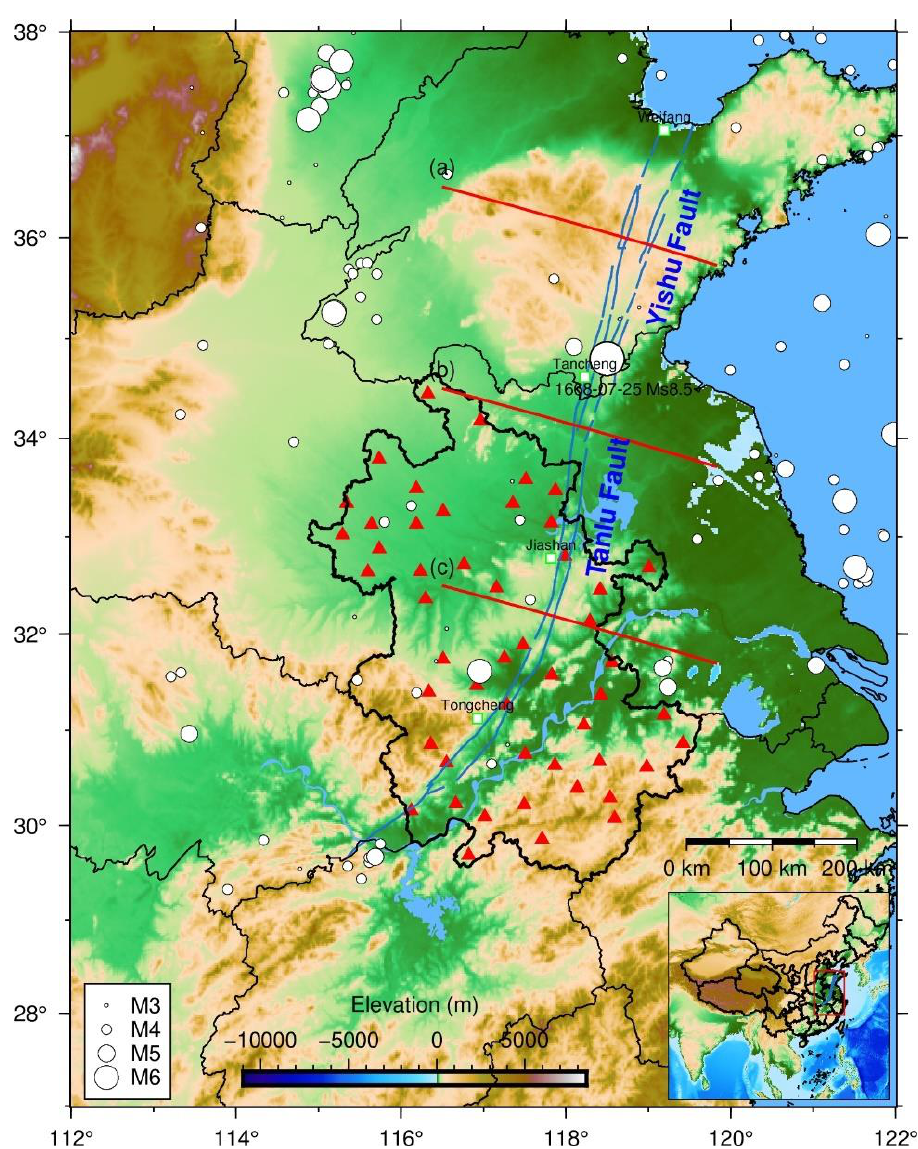
Figure 1. Distribution map of Anhui CORS stations. The red triangles are where the Anhui CORS stations are located. White circles show earthquakes with 3.0 ≤ M s ≤ 8.5 from 1 January 1900 to 31 December 2020 (https://earthquake.usgs.gov, accessed on 14 December 2021). The largest white circle is an M s 8.5 earthquake that struck Tancheng on 25 July 1668. The blue broken line represents the central and southern segments of the Tanlu fault zone, and the Yishu fault zone is a part of the Tanlu fault zone in Shandong Province. The three red lines labeled by ( a – c ) represent the locations of three velocity profiles across the Tanlu fault zone. Table 1. Data processing strategy.